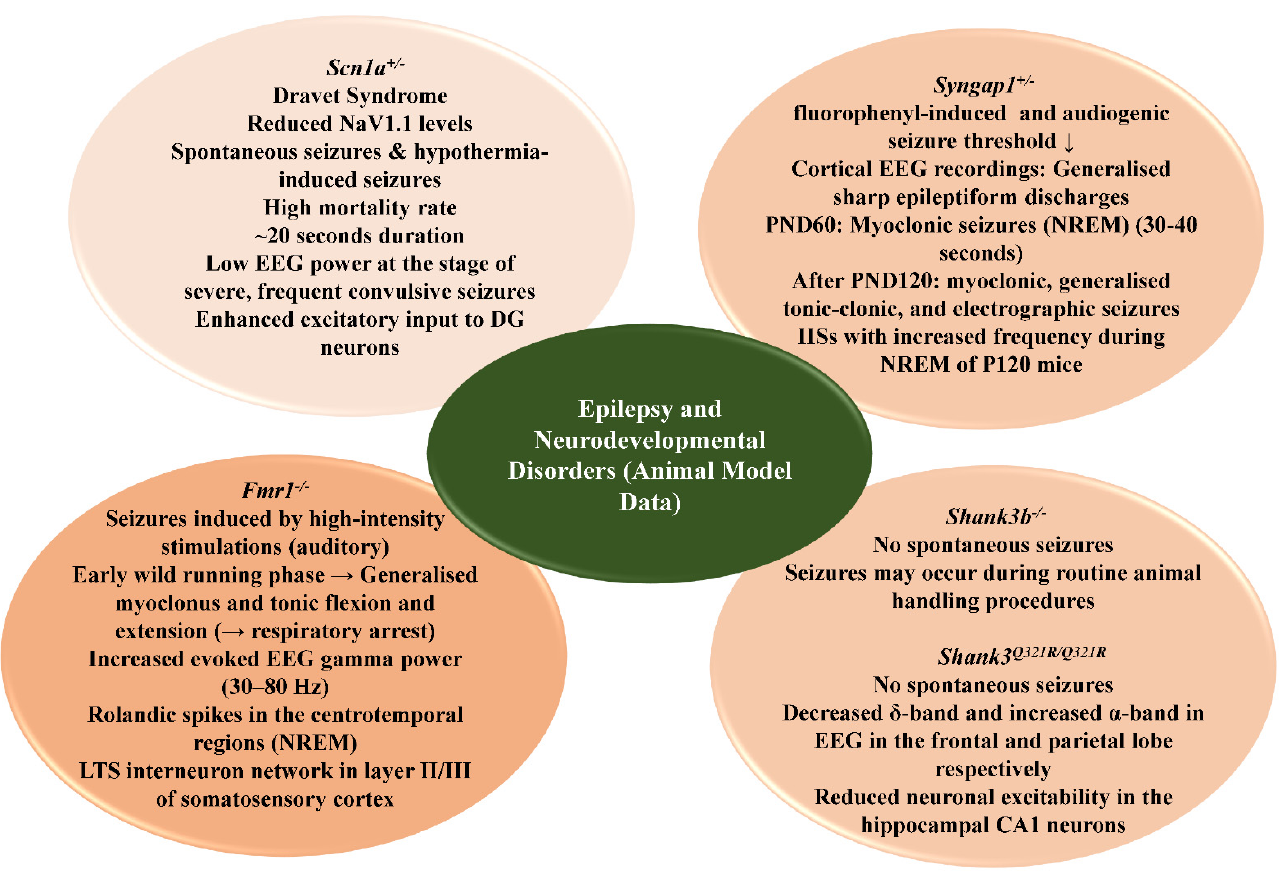
Figure 2. Common pathophysiological features of epilepsy in animal genetic models associated with NDDs. Diagram illustrating neurodevelopmental phenotypes, predominant seizure types, and elec- troencephalographic hallmark characteristic features observed in genetically developed mouse models of neurodevelopmental disorders displaying epileptic